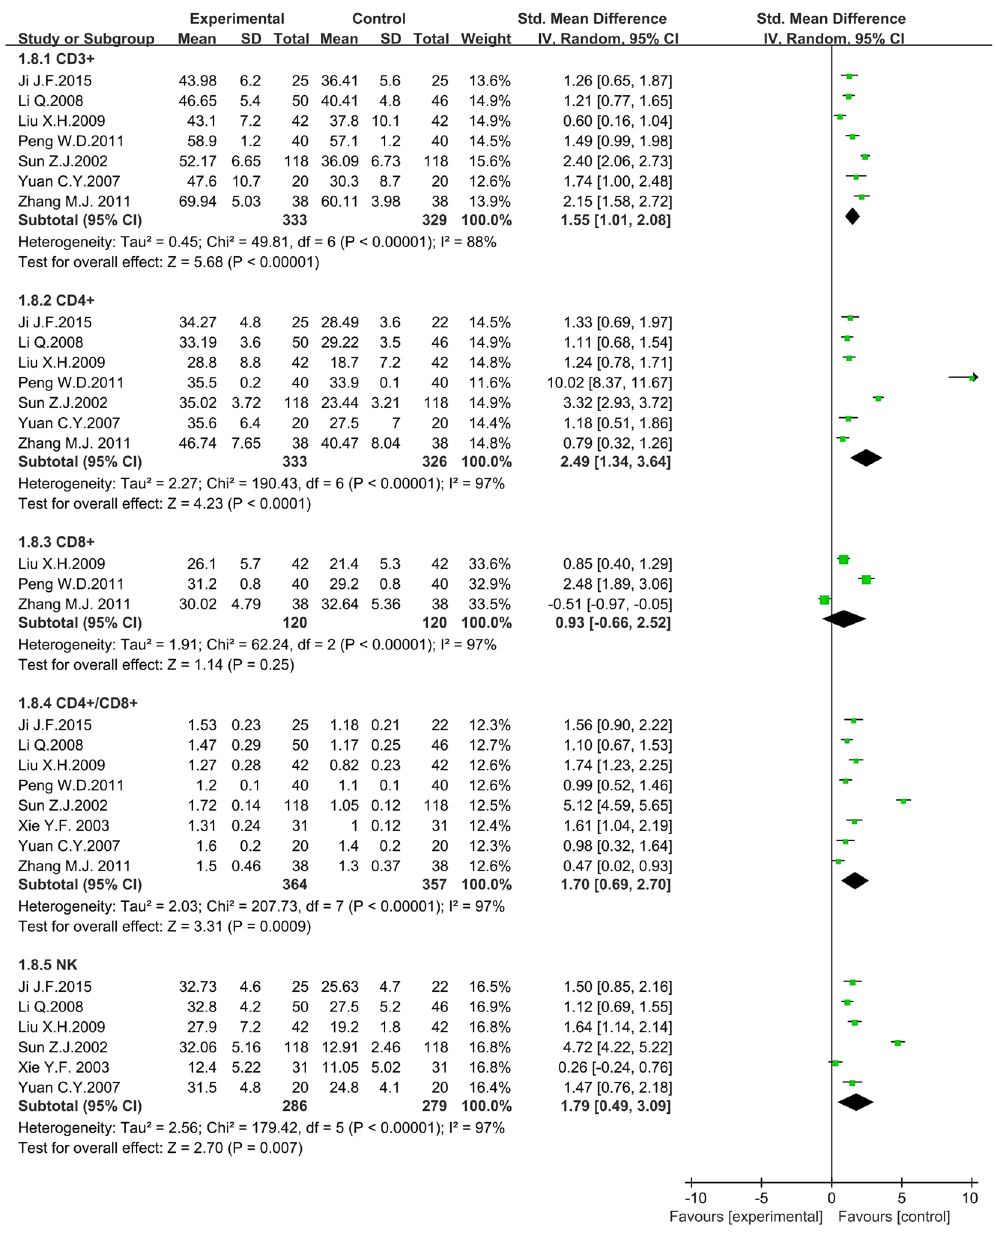
Funnel plot characteristics. We applied the pooled odds ratio (OR) as the midpoint to draw the funnel plot (Fig. 11). The publication bias was evaluated in the funnel plot by comparing the symmetry of included studies on objective response rate. The funnel plot was symmetrical in visual while the images (Fig. 12) and calculating results of Egger’s test ( t = − 2.96, P = 0.005) and Begg’s test ( z = 1.96, P = 0.092) indicated the potential publication bias did